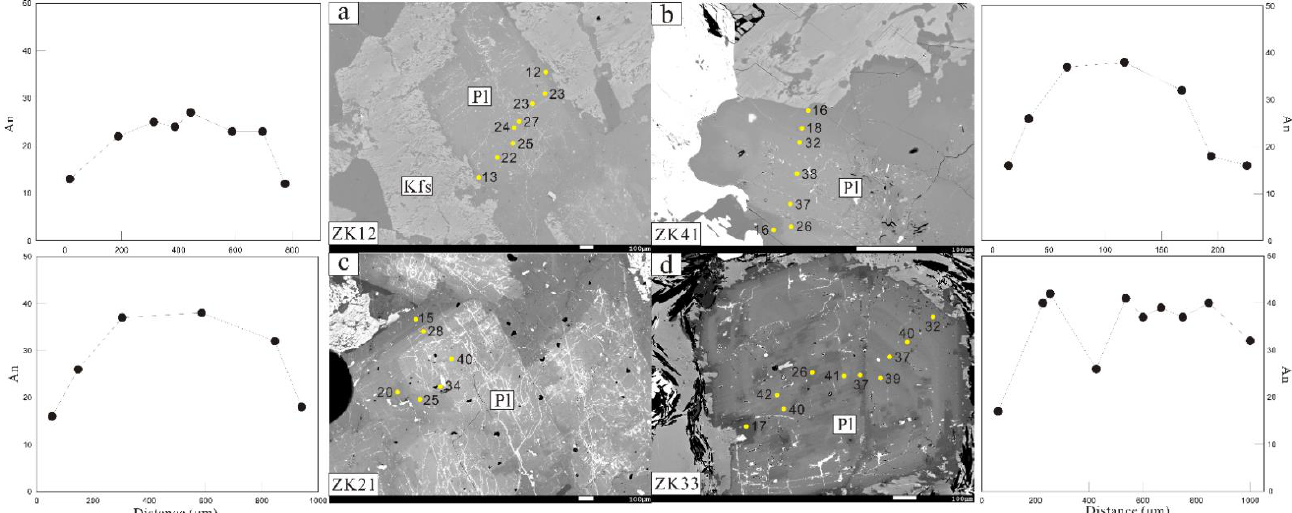
Figure 10. BSE images illustrating the petrographic characteristics of plagioclases in the granites and the graphite orbicules and their An (anorthite composition) variation trends. The numbers represent the An in plagioclase. ( a , b ) Plagioclase in granites showing high-An cores and low-An rims. ( c ) Plagioclase in the light-colored core of graphite orbicules having andesine core and oligoclase rim. ( d ) A plagioclase phenocryst surrounded by graphite having relatively high An and occasional oscillatory zoning.